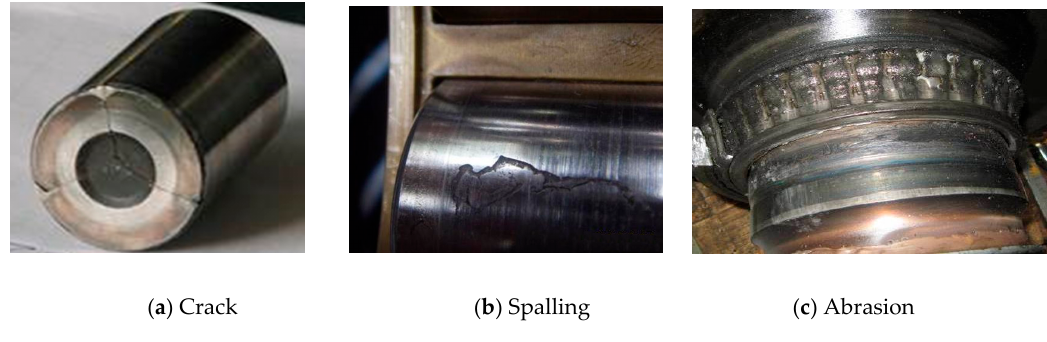
Figure 1. Different railway axle bearing defects.